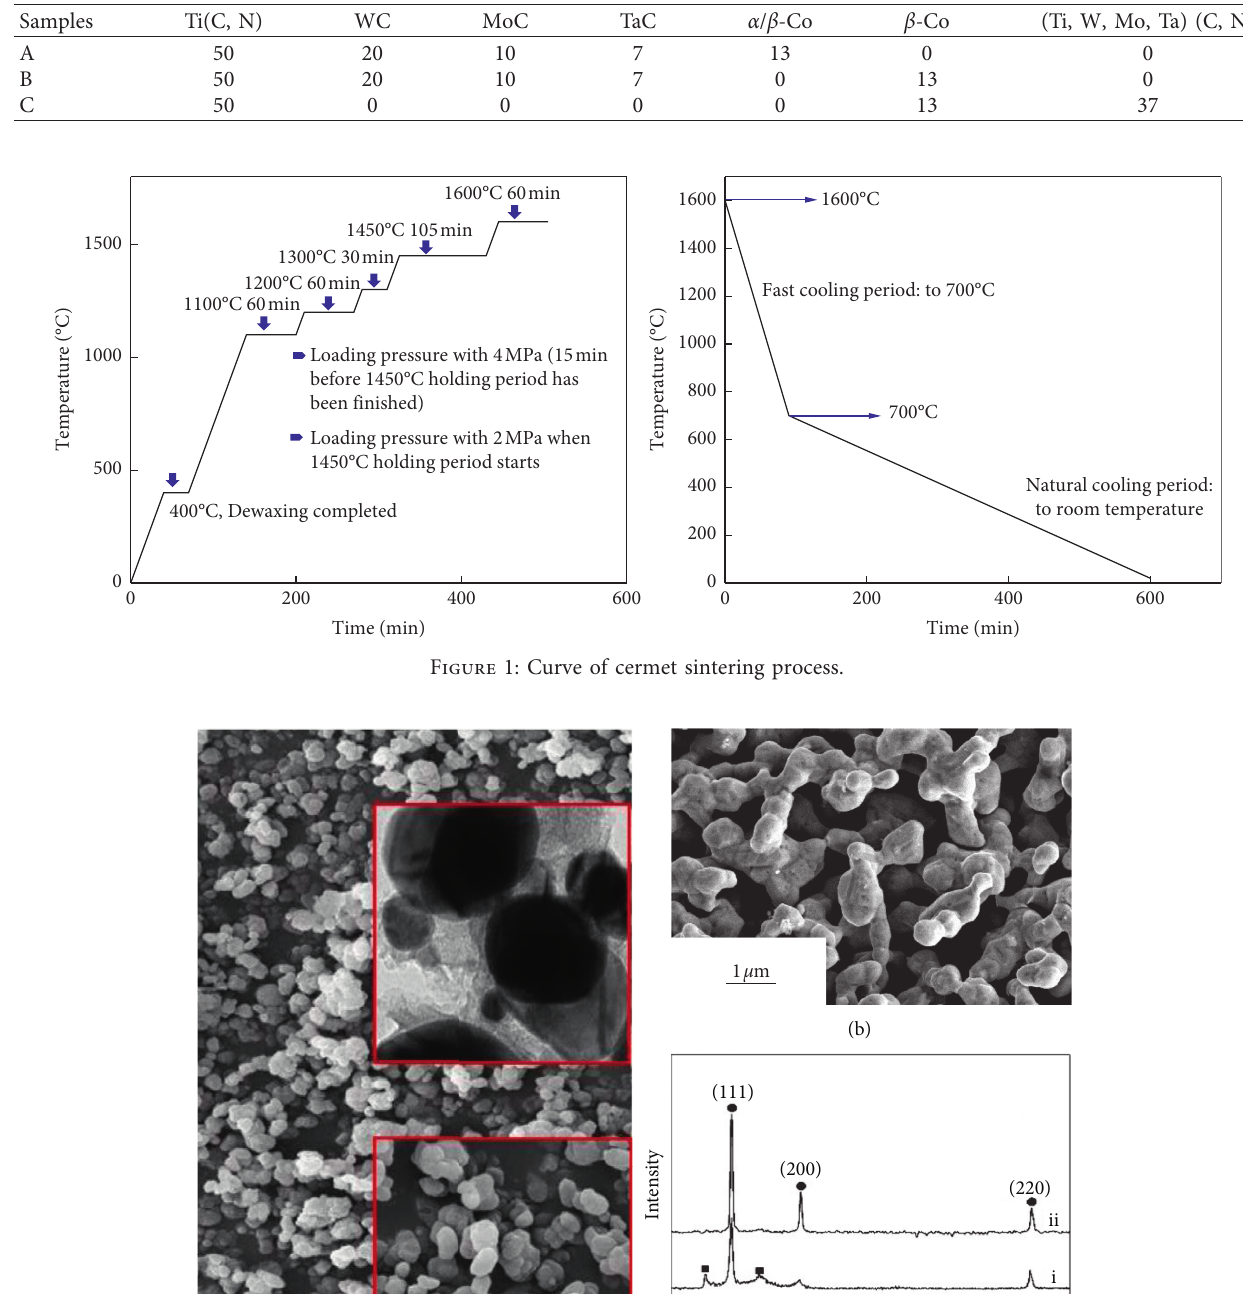
Table 1: Composition of powder mixtures for the Ti(C, N)-based cermet